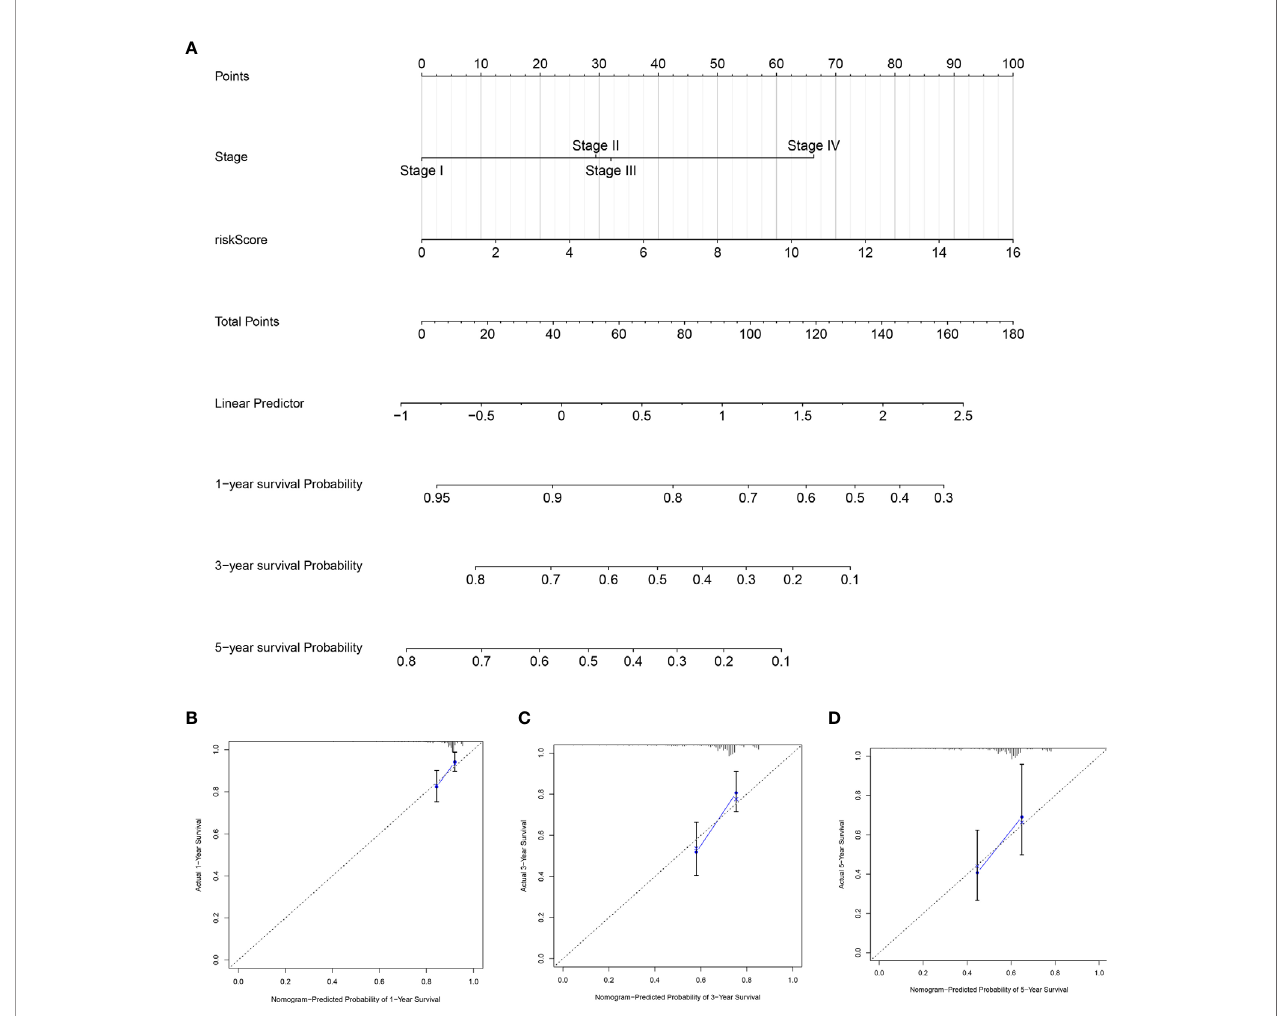
FIGURE 10 | Construction of nomogram to predict the prognostic ability for the DFS in the complete dataset based on the independent factors. (A) A nomogram was constructed based on the independent prognosis factors to predict the prognosis of GC. The calibration plots for 1- (B) , 3- (C) and 5-years (D) in the complete